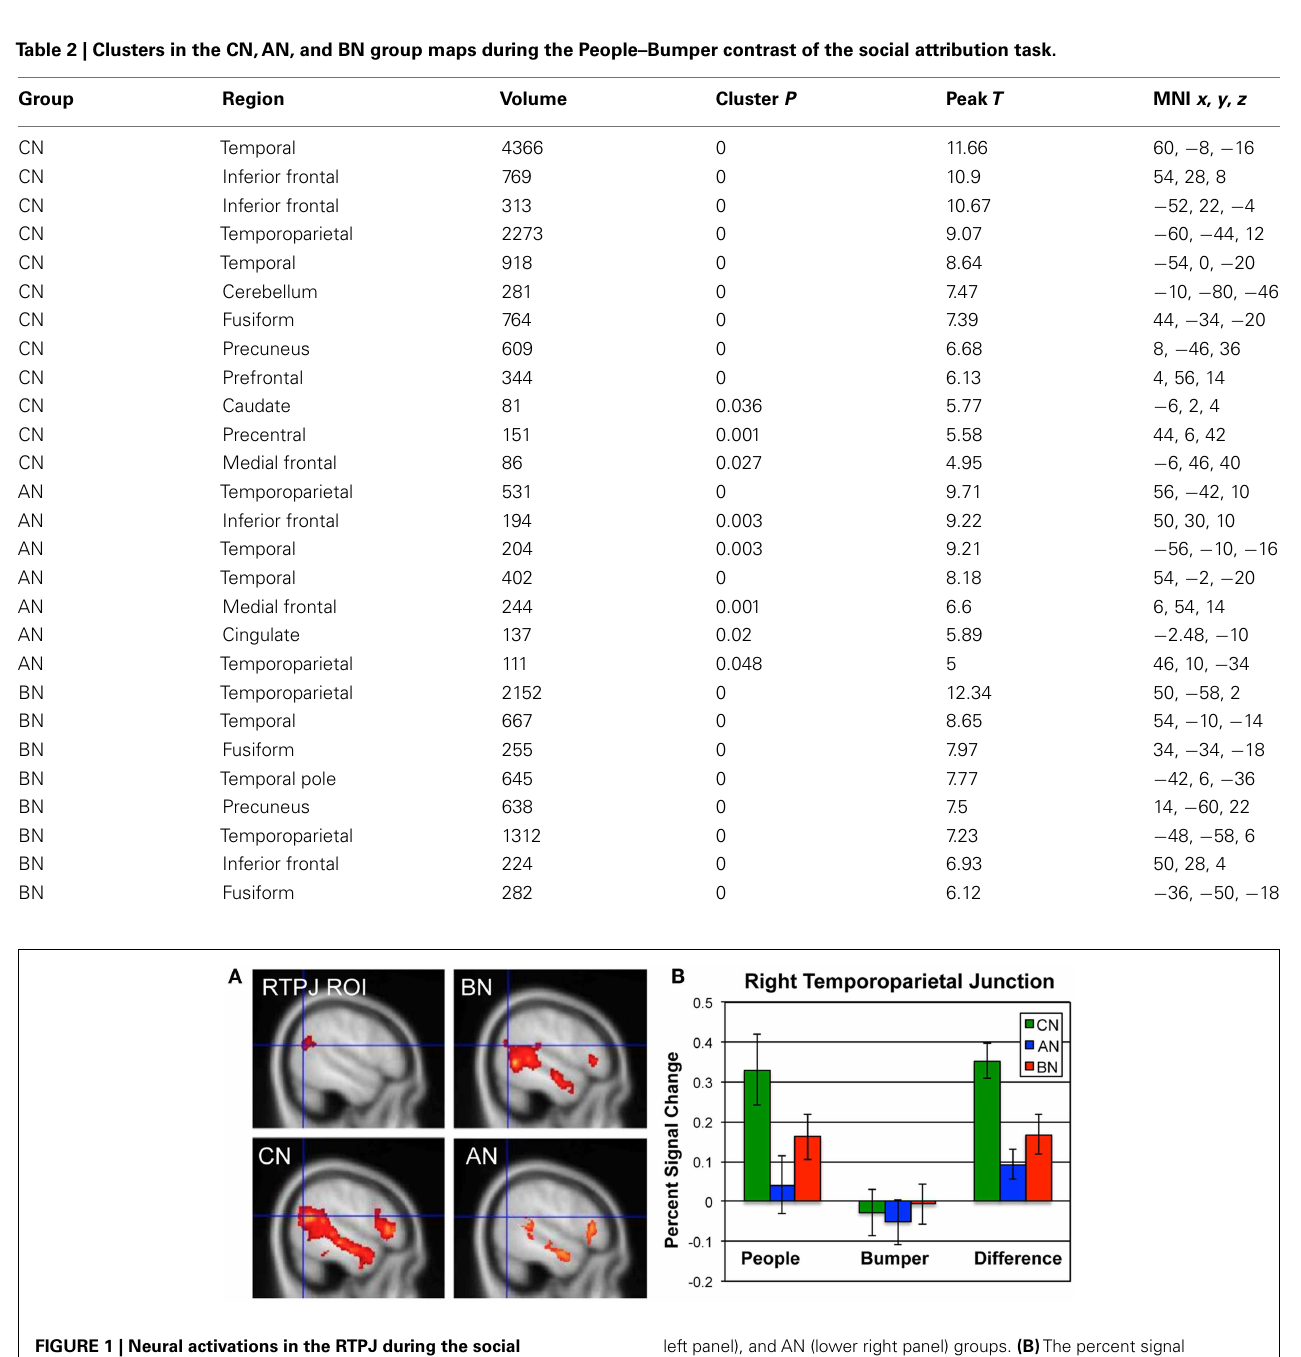
FIGURE 1 | Neural activations in the RTPJ during the social attribution task . (A) The RTPJ ROI is shown in the upper left, and the group maps for the People–Bumper contrast are all shown at sagittal coordinate x = 52 for the BN (upper right panel), CN (lower